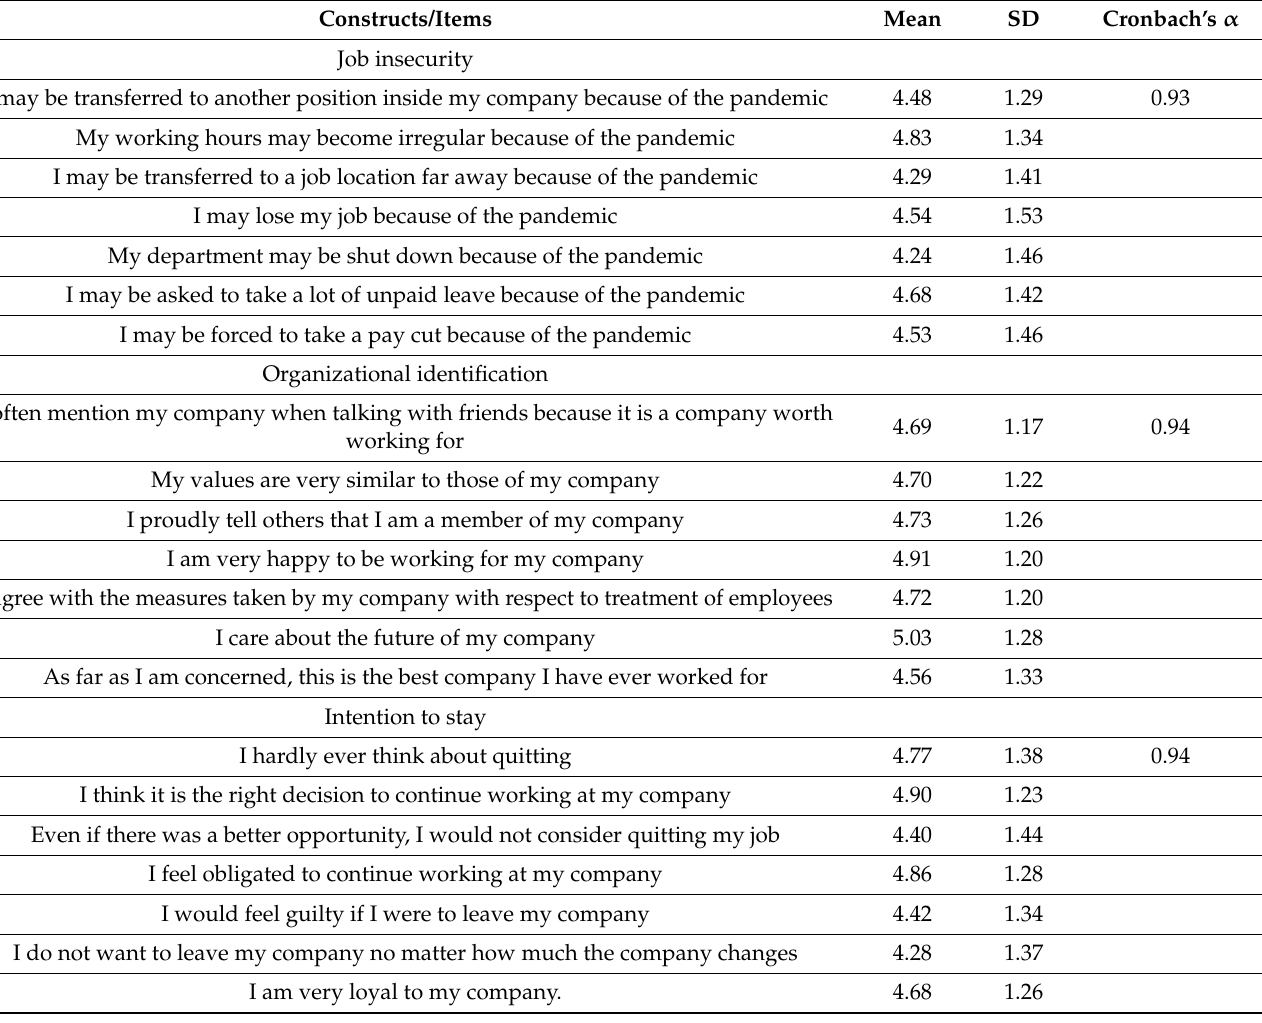
Table 1. Descriptive